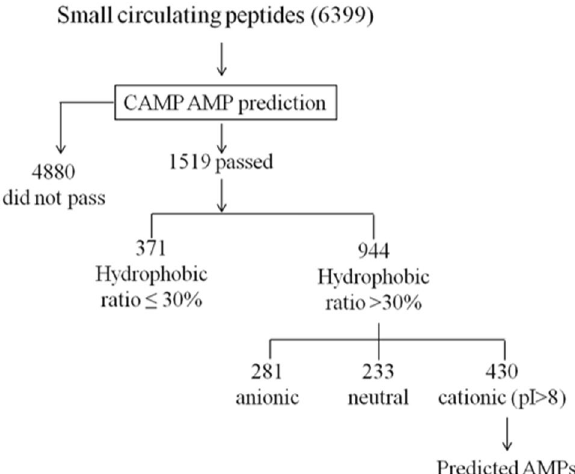
Figure 2. The AMP prediction pipeline of this study.